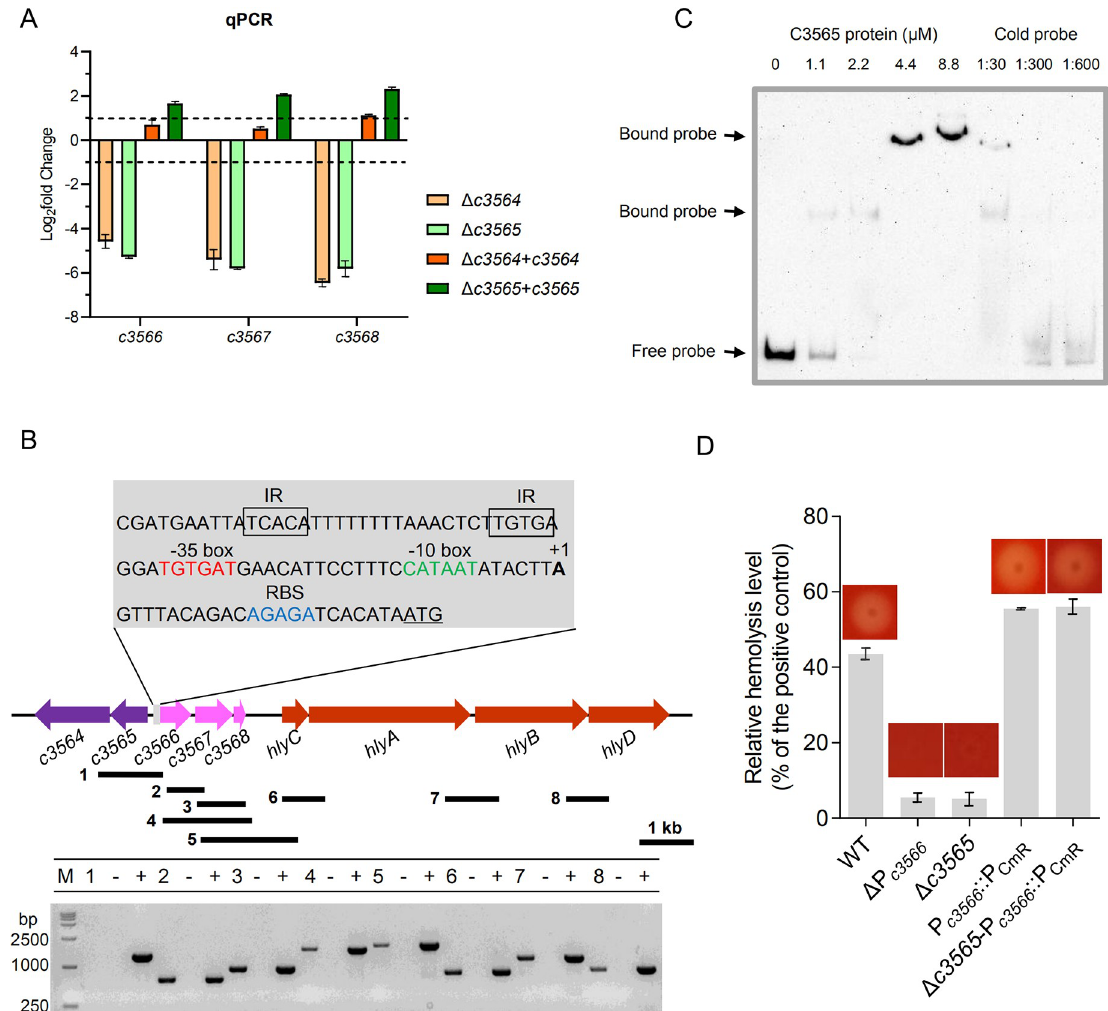
Fig 4. c3566 - c3568 transcription and hlyCABD transcription are linked and controlled by c3564 and c3565 . (A) qPCR analysis indicates that c3564 and c3565 positively regulate the expression of c3566 - c3568 expression. Bacteria were collected by scraping off the plates and immediately stabilized in RNAlater reagent. Total RNA was isolated and reverse transcribed to cDNA. The rpoB gene was used as an internal control, and the 2 - ΔΔ Ct method was employed to determine fold-changes in CFT073 variants compared to the wild type. Dashed lines represent a 2-fold change cutoff, and a fold-change � 2 was considered significant. Values are the mean ± SD of three replicates from 3 independent experiments. (B) RT-PCR analysis indicates that the c3566 - c3568 operon and hlyCABD operon are cotranscribed. RNA and cDNA samples were prepared as described above. The black bars under the gene arrows denote the PCR amplicons generated during testing of cotranscription, and the number in front of each bar corresponds to the lane in the agarose gel. The #1 fragment was used as a negative control reaction, as c3565 and c3566 do not cotranscribe. RNA that was not reverse transcribed served as a negative control template, while genomic DNA served as a positive control template. 5’-RACE PCR was used to identify the TSS (+1) of the c3566 - c3568 operon, and the -10 and -35 motifs were deduced afterward. Gray box, promoter region of c3566 ; underlined ATG, start codon; blue letters, ribosomal binding site; green letters, -10 box; red letters, -35 box; boxed letters, inverted repeats (IRs) likely bound by the C3565 protein. The genes are drawn to scale. (C) EMSA analysis of C3565 protein bound to the c3566 promoter region. C3565-His 6 recombinant protein was purified to homogeneity, and the biotinylated c3566 promoter fragment was used as a probe. Concentrations of the proteins and the ratios of cold probe to the biotinylated probe were indicated above the image. (D) Hemolysis is regulated by the c3566 promoter (P ). Hemolysis assays with liquid blood and blood agar were performed on various CFT073 strains. Strain names represent: c3566 WT, wild-type CFT073; Δ P c3566 , c3566 promoter deletion mutant; Δ c3565 , c3565 deletion mutant; P c3566 ::P CmR , a mutant in which c3566 ::P CmR , a mutant in which c3565 is deleted and c3566 promoter is replaced by P CmR . All promoter is replaced by P CmR ; Δ c3565 -P c3566 images are representative of at least two independent experiments, each containing 3